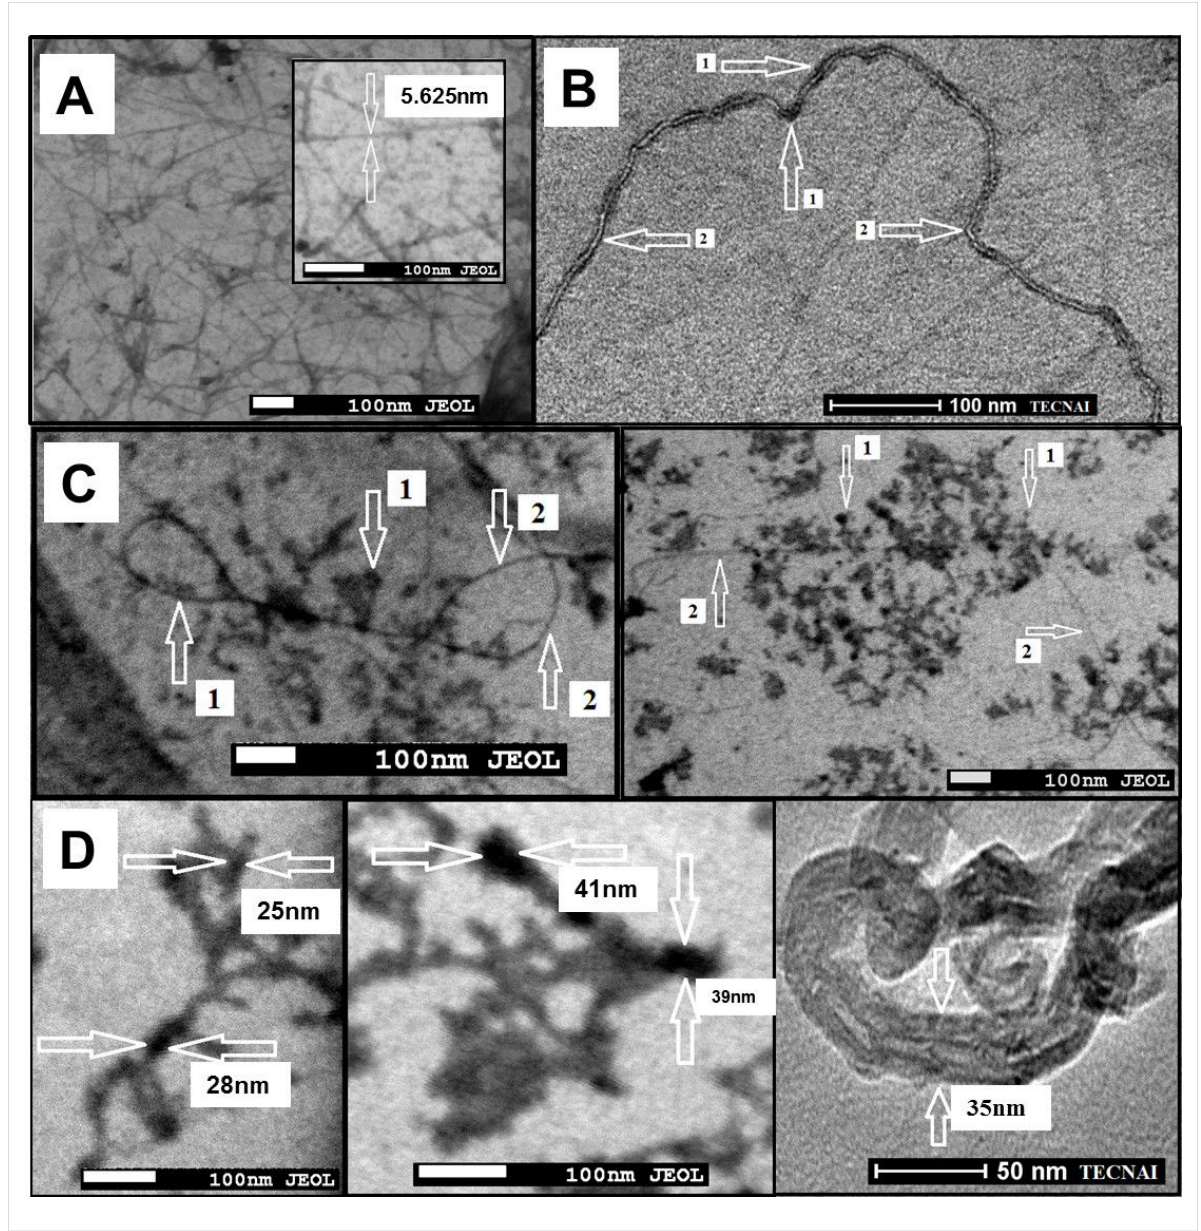
Figure 9: Transmission electron microscope images. (A) SWNTs dispersed by sodium cholate; the diameter of the individual SWNT – 5.6 nm; (B) SWNT–CR complex created at low 1:1 CR/SWNT ratio (1 mg SWNTs + 1 mL of 1 mg/mL CR). Arrows indicate (1) CR binding sites and (2) CR-free areas (Tecnai, Osiris); (C) SWNT–CR complexes formed at 5:1 CR/SWNT ratio (1 mg SWNT + 1 mL of 5 mg/mL CR): nanotubes unevenly covered with CR are visible. Arrows indicate (1) CR binding sites and (2) CR-free areas. The diameter of SWNT–CR complex exceeds 20 nm in thickest areas (Jeol); (D) SWNT–CR complexes formed at very high 10:1 CR/SWNT ratio (1 mg SWNTs + 1 mL of 10 mg/mL CR): CR covers the entire surface of carbon nanotubes, the diameter of SWNT–CR complex exceeds 40 nm in thickest areas.